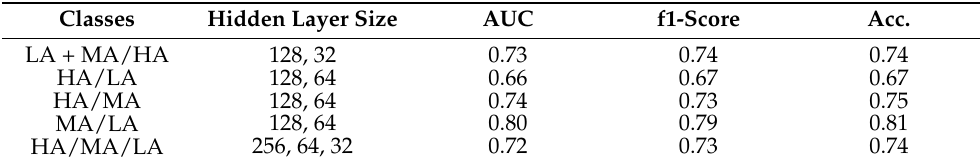
Table 9. EA classification results.